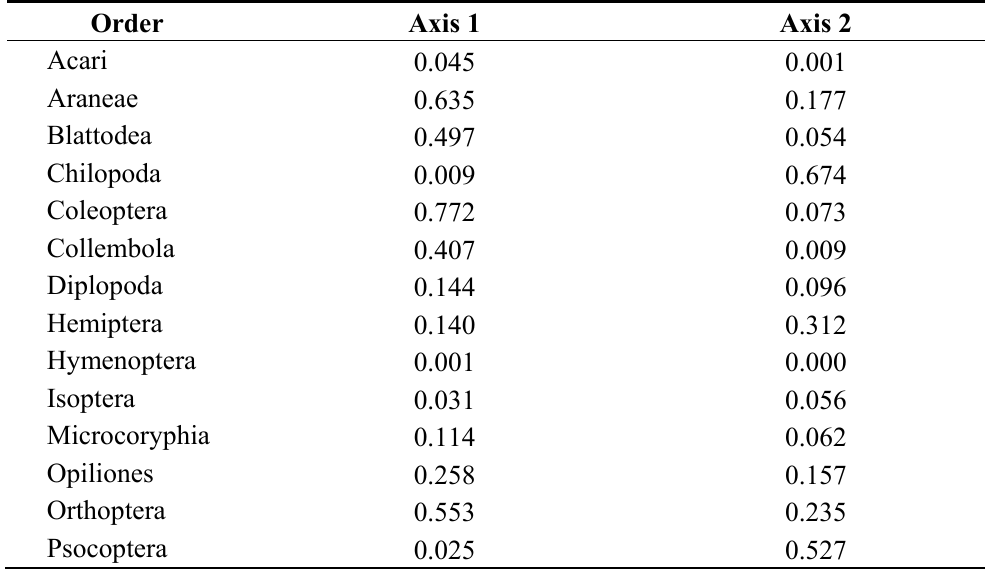
Table 3. Pearson correlation coefficients between NMS ordination axes and the 14 dominant orders of arthropods